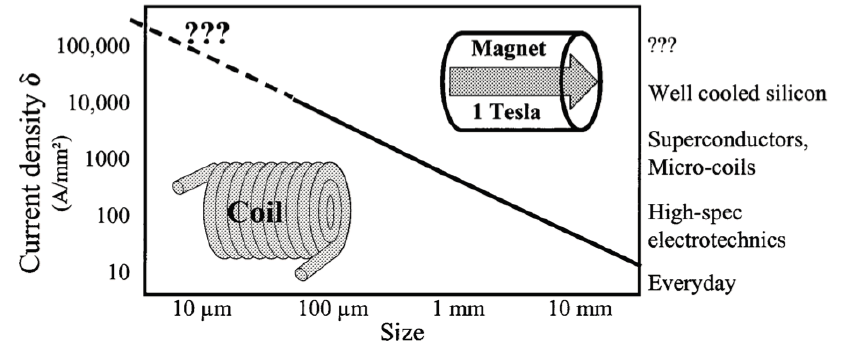
Figure 6. Scaling of the current density in a microcoil for equivalence to a 1 T permanent magnet of the same size [128]. Reprinted with permission from [128]. Copyright 2003